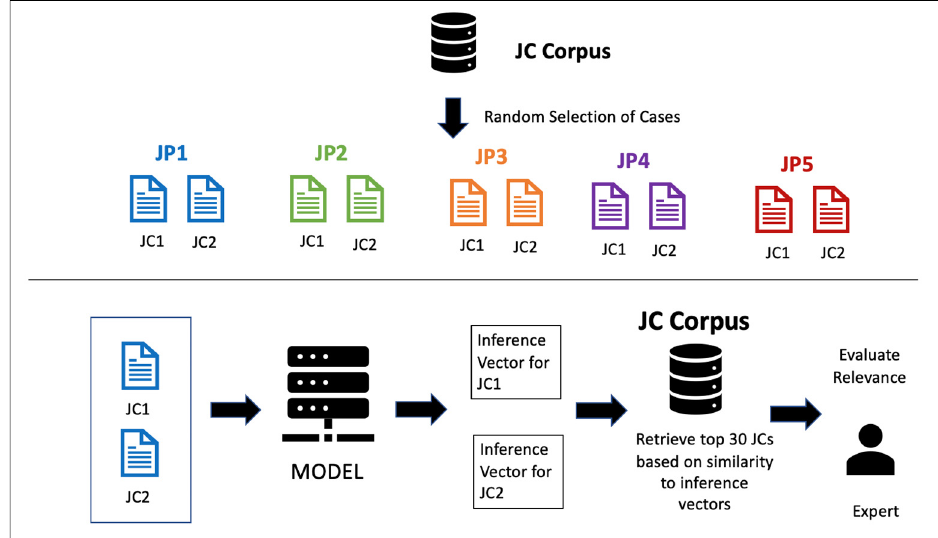
Figure 1. The evaluation process.